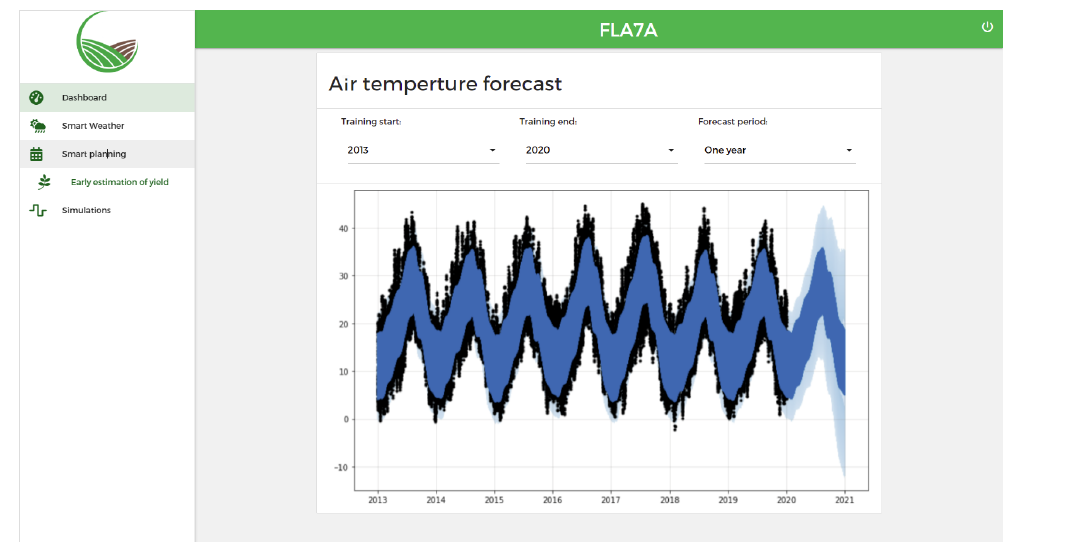
Figure 15. A screenshot of the platform’s forecast service. The light blue is the uncertainty bounds of the uncertainty interval around the final predictions (upper and lower), while the dark blue is the predicted values, and the black dots represent our original